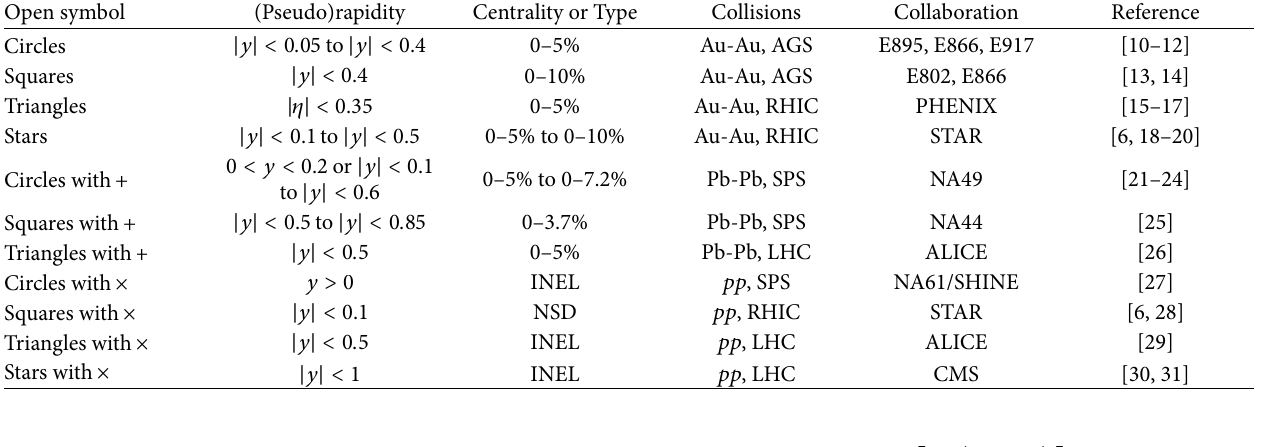
Table 1: The (pseudo)rapidity intervals, centrality ranges or collision types, and collision systems corresponding to the yield ratios quoted in Figure